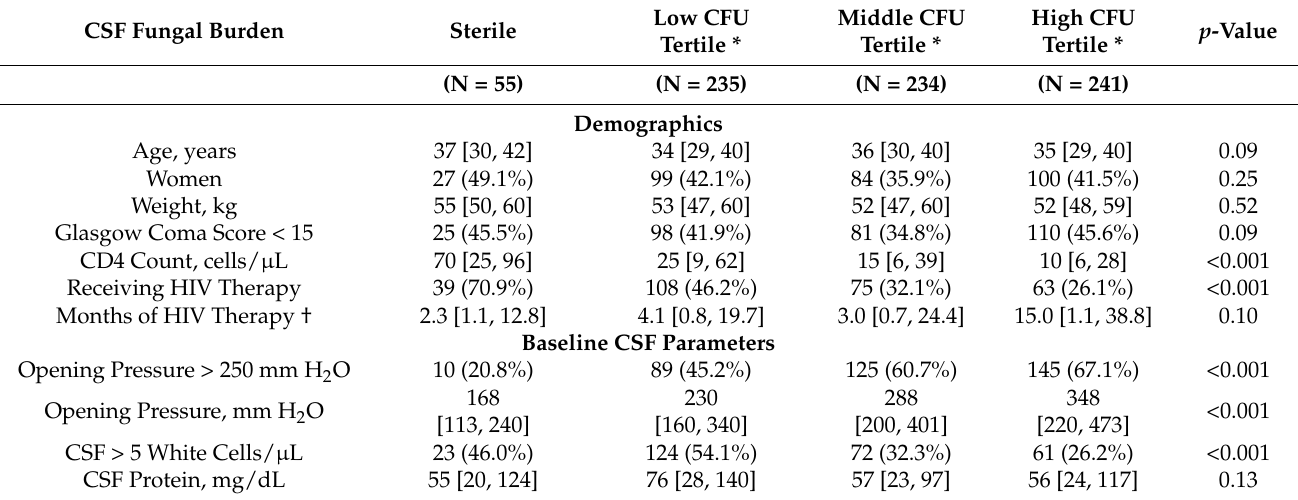
Table 1. Baseline characteristics by CSF quantitative culture burden in first-episode HIV-related cryptococcal